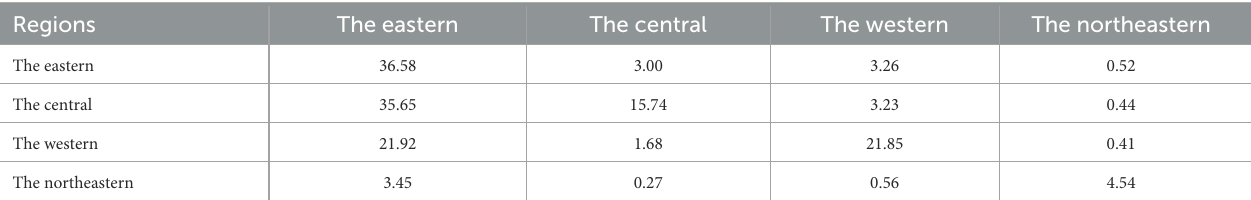
TABLE 2 The statistics of intercity migration flows between four economic regions (million). Regions The eastern The central The western The